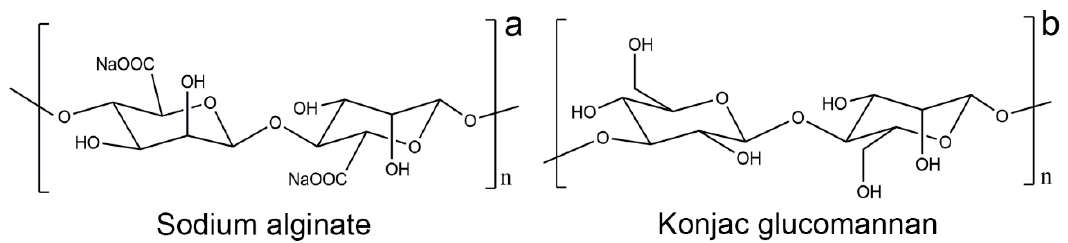
Figure 1. Chemical structure of ( a ) sodium alginate and ( b ) konjac